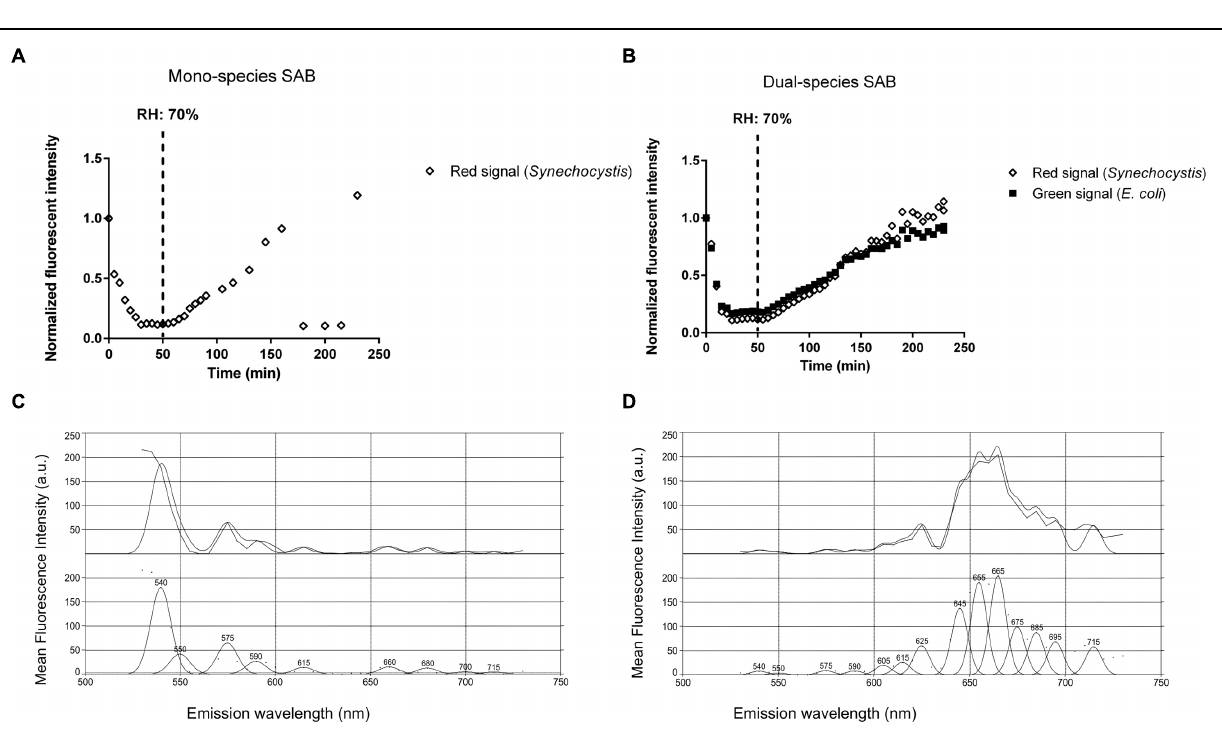
FIGURE 4 | Biofilm recovery after desiccation. Recovery of fluorescence of a mono (A) and dual-species SAB during rewetting (B) . Emission spectra recorded in cyanobacterial cells before (C) and after (D) rewetting. Spectral profiles were analyzed by PICKFIT deconvolution software to show individual phycobiliproteins: Phycoerythrin, 575 nm; Phycocyanin, 645 nm; Allophycocyanin, 665 nm; Chlorophyll a , 685 nm (Wolf and Schübler,